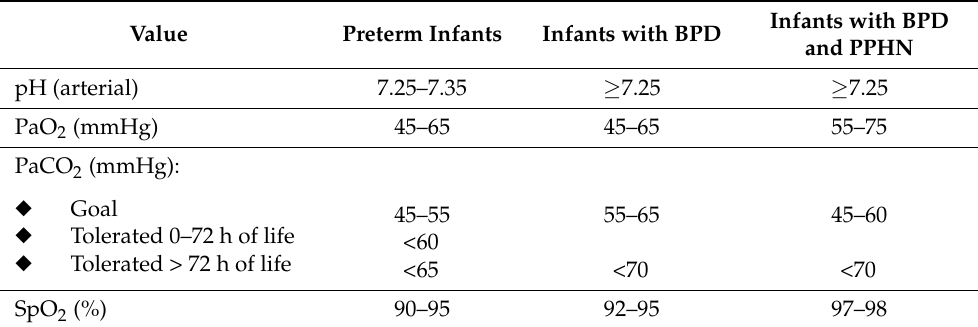
Table 2. Suggested goals of mechanical ventilation in preterm infants during NICU